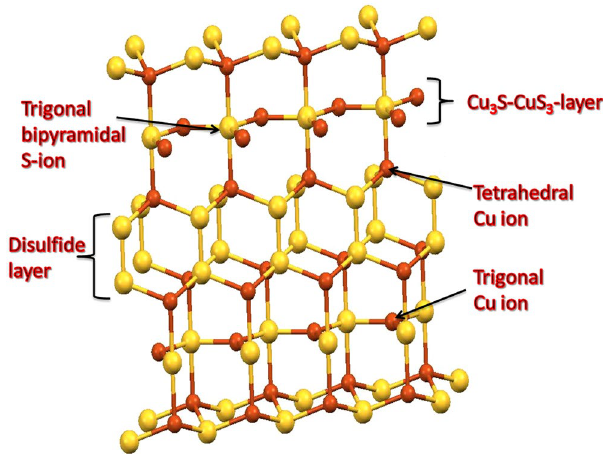
Figure 1. The crystal model of copper sulfide